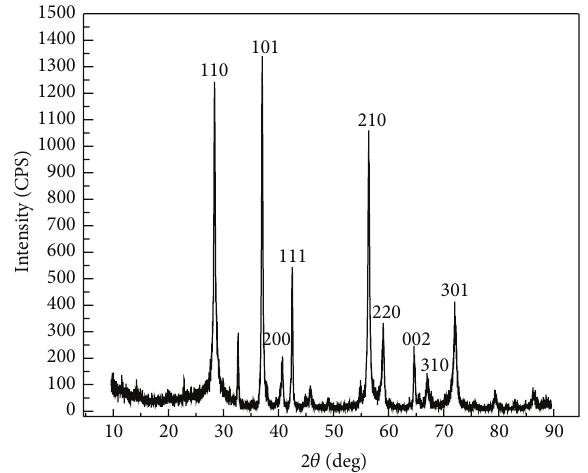
Figure 1: XRD pattern of the sample of blank.